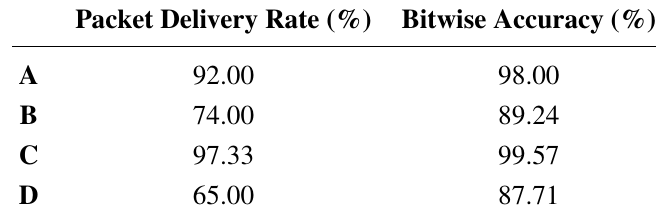
Table 1. Packet delivery rates and bitwise accuracies on four different communication medium